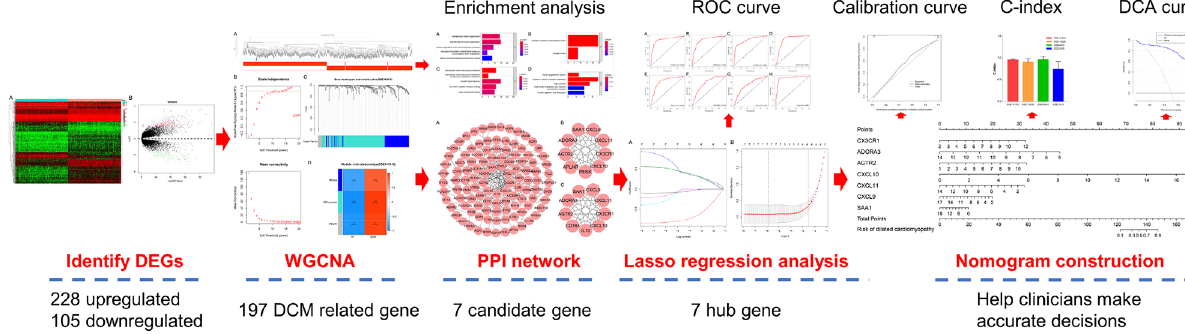
Figure 1. Flow chart of this research.